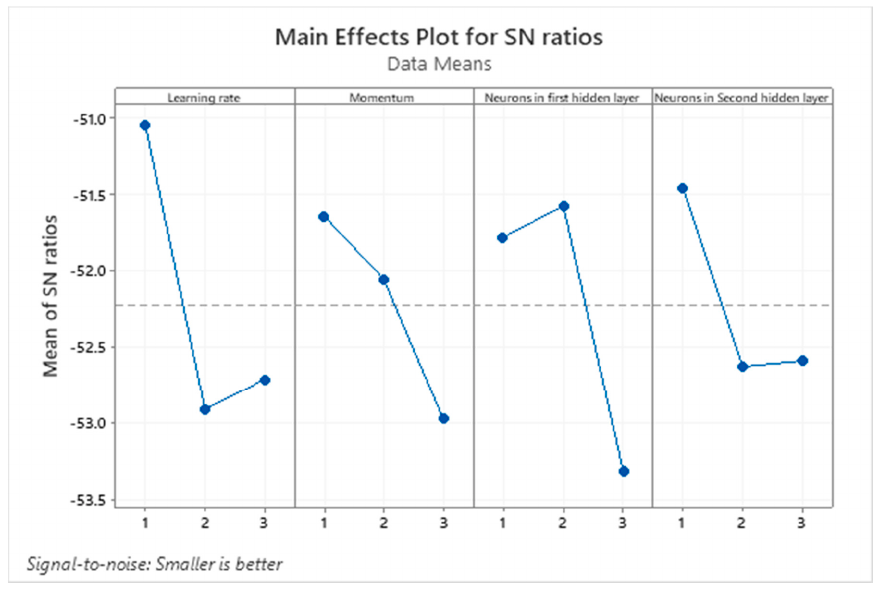
Figure 4. Main effect plot for S/N ratio while using the NARX neural network-based algorithm. Figure 4. Main e ff ect plot for S / N ratio while using the NARX neural network-based algorithm. Table 4. Results of the NARX neural network-based